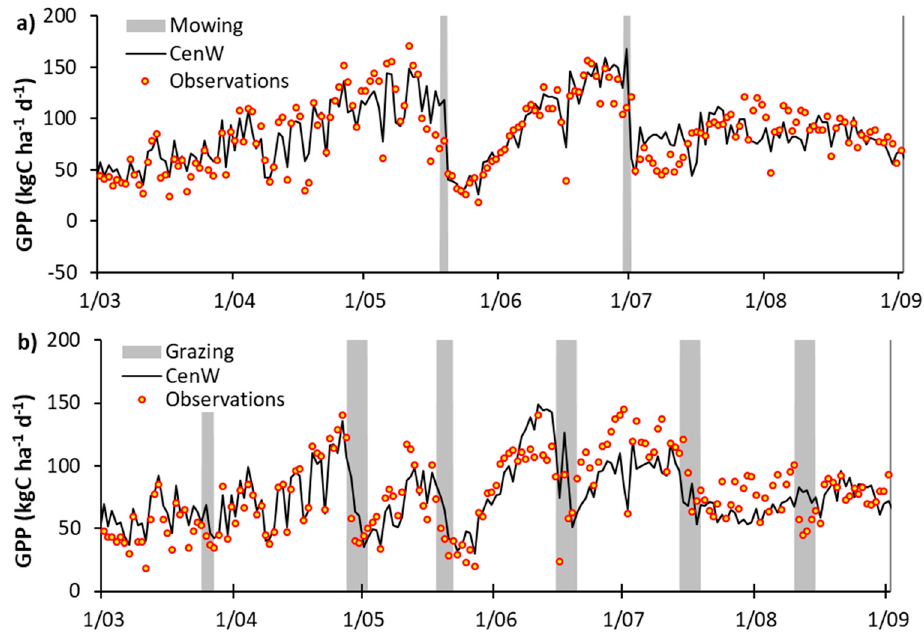
Figure A1. Daily time series of EC derived (dots) and modeled (black line) GPP for a) the mowed and b) the grazed grassland sites over 6 months (March to end August) of 2008. Vertical gray areas represent the recorded timing of harvests and grazing events for the two selected paddocks.